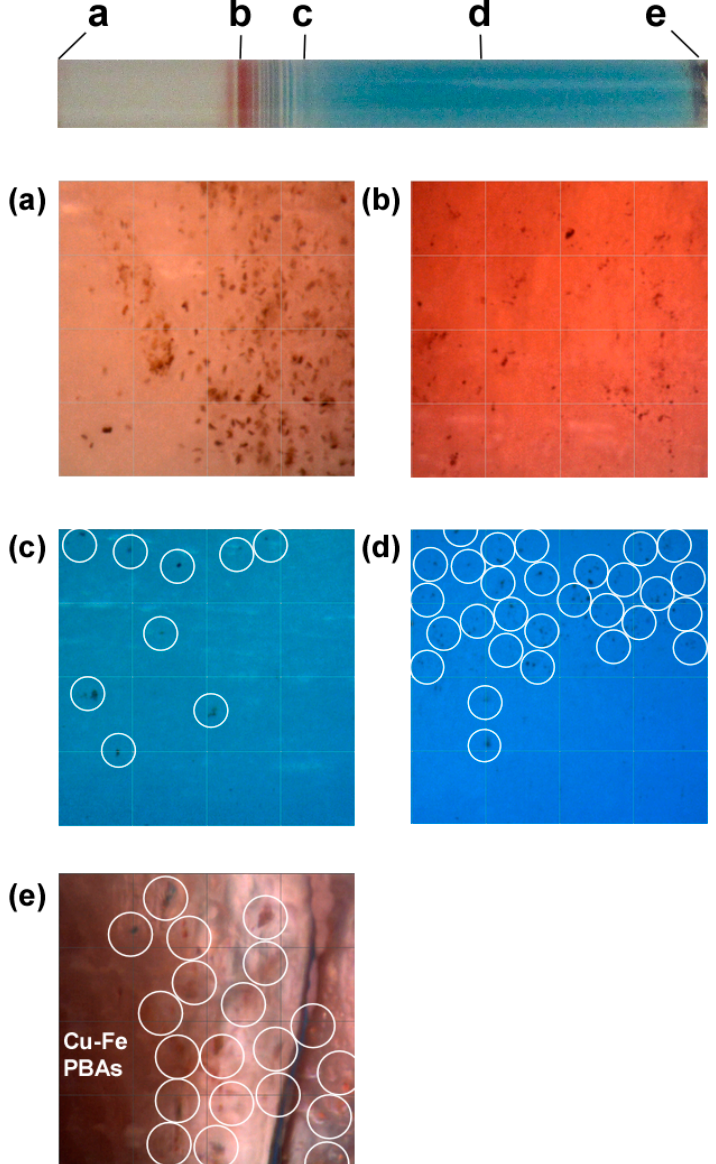
Figure 12. Microscopic images ( × 1000) of the multicolored pattern formed under the cyclic alternating voltage application, obtained after removing unreacted ions. The positions where these microscopic images were acquired are indicated in the uppermost panel. The size of the grid boxes in each image (which were employed for estimating sizes of the crystallites) is 50 µ m. The crystallites observed in ( c – e ) are indicated by white circles to guide the